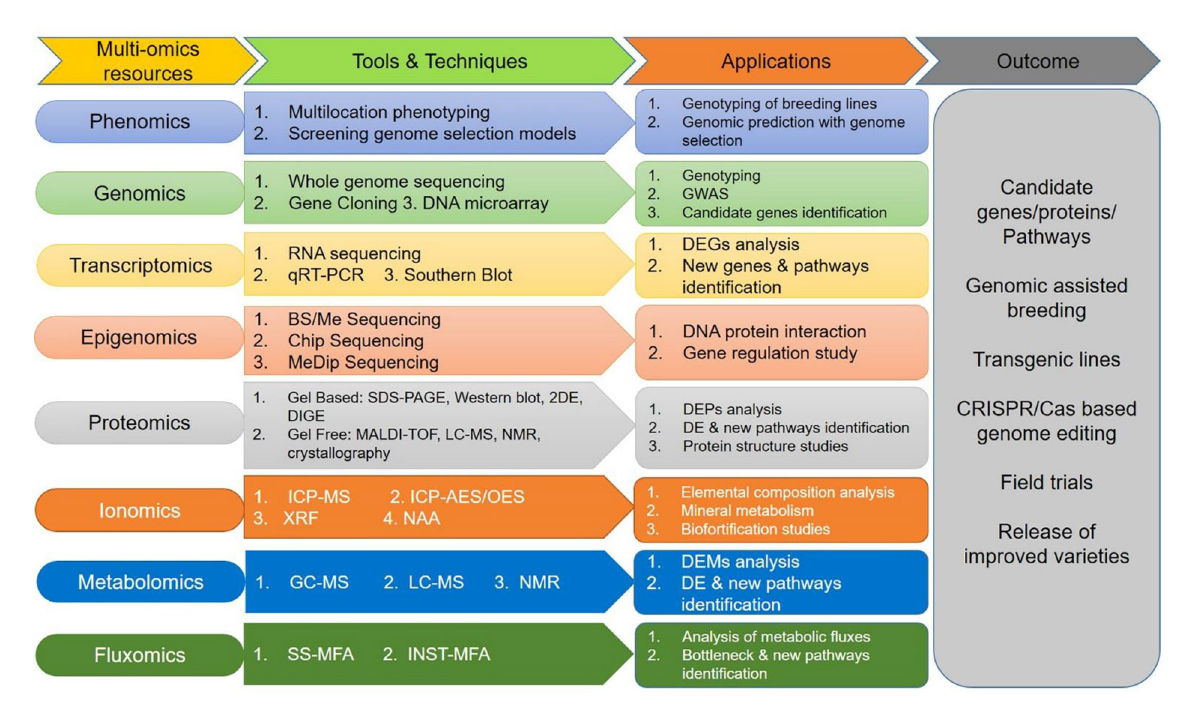
FIGURE5 A “multi-omics” strategy for genetic improvement for mainstreaming millets for climate smart agriculture. GWAS, genome-wide association studies; BS/Me-Seq, bisulfite/methyl-sequencing; ChIP-Seq, chromatin immunoprecipitation and MeDip; Seq, Methylated DNA immunoprecipitation sequencing; qRT-PCR, Real-time quantitative reverse transcription polymerase chain reaction; 2DE, two-dimensional gel electrophoresis; DIGE, two-dimensional difference gel electrophoresis; MALDI-TOF, matrix-assisted laser desorption/ionization-time of